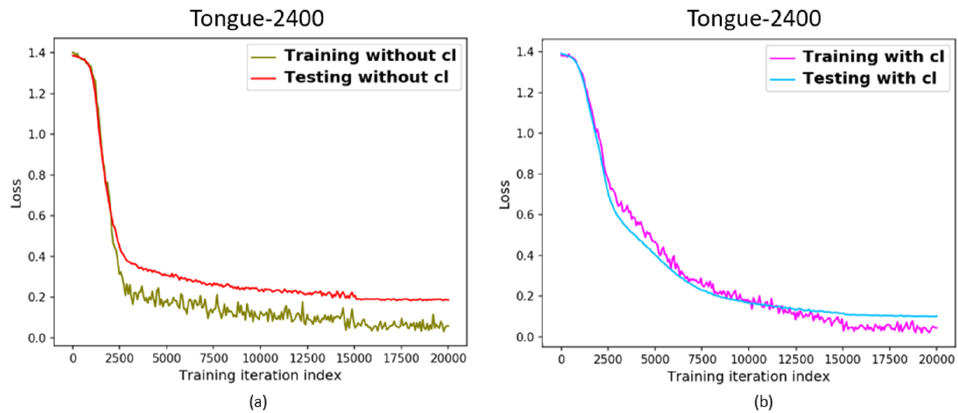
Figure 12. Influence of center loss in training phase: ( a ) without center loss; ( b ) with center loss. (6)